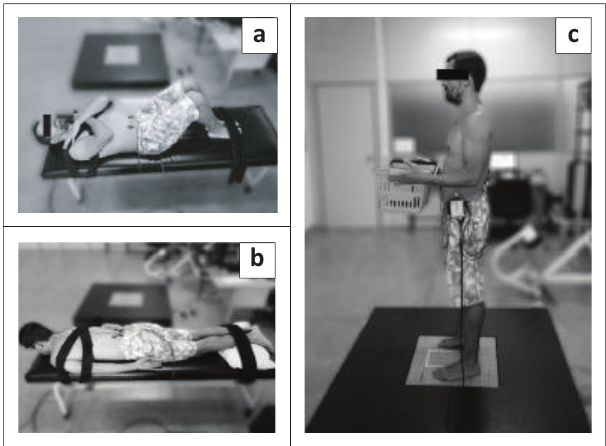
FIGURE 2: Positioning and stabilisation during the abdominal (rectus abdominis) (a) and paravertebral (multifidus-L5 and iliocostalis-L3), (b) neuromuscular activity measuring and (c) bipodal support with